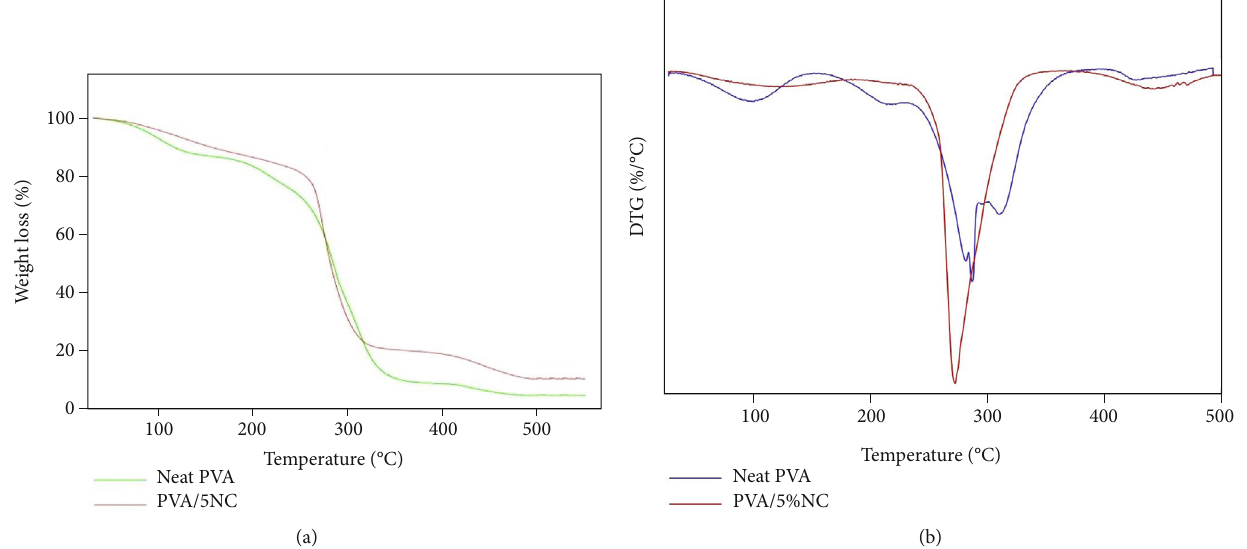
Figure 4: Thermal degradation of PVA-0%NC and PVA-5%NC composite fi lms. (a) TGA curves and (b) DTGA curves.